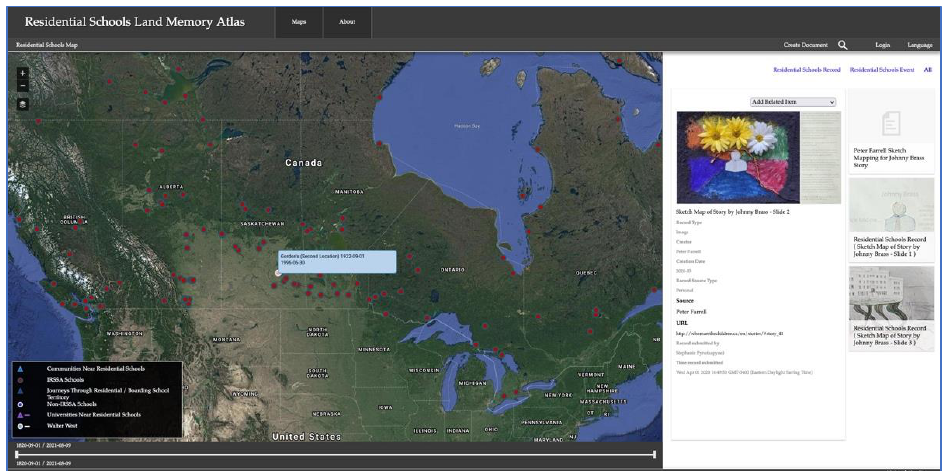
Figure 5. Screenshot of Residential Schools Map of the Residential Schools Land Memory Atlas, showing a document view and thumbnails of the sketch mapping by Peter Farrell for Johnny Brass’s story in the side panel and the location for Gordon’s Residential School in the center map panel (The media depicted in Figures 5 and 6 are available at: https://residentialschoolsatlas.org/index.html?module=module.residential_schools#eyJ0IjoieCIsImkiOiIxMzE4NGNkZTdjODViZGZkODA5MzdmZDkzZjU3M2M5ZCIsInMiOjE2NDQ4NjQ5MzgyODR9, (accessed on 1 April 2022)).